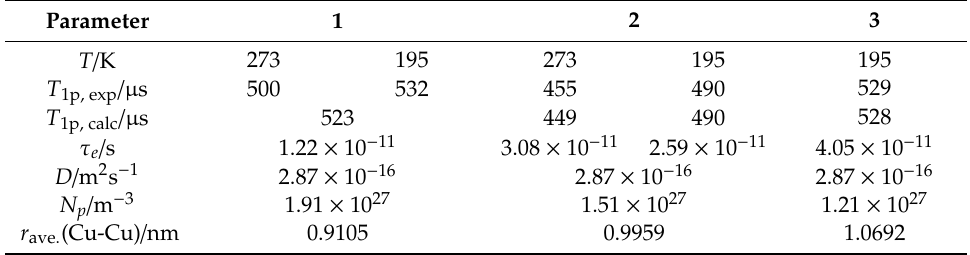
Table 4. 1 H T 1 via paramagnetic centers, electron longitudinal relaxation times, di ff usion coe ffi cients for spin di ff usion, spin densities, and average interlayer Cu-Cu distances in ELM-11.